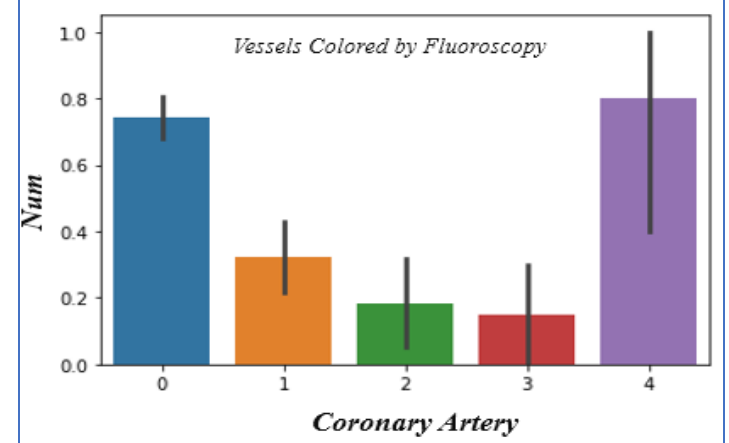
Figure 11. Coronary Artery vs. disease chances.